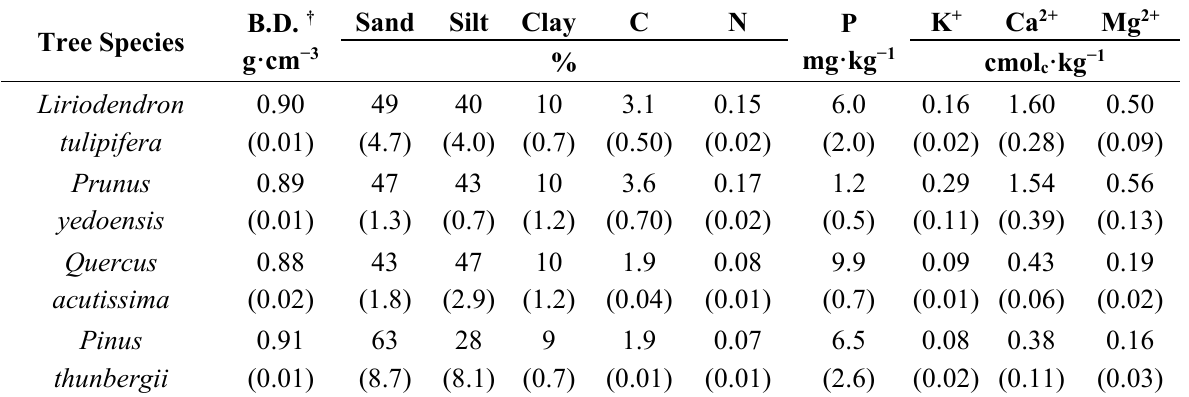
Table 2. Soil property before fertilization in the study